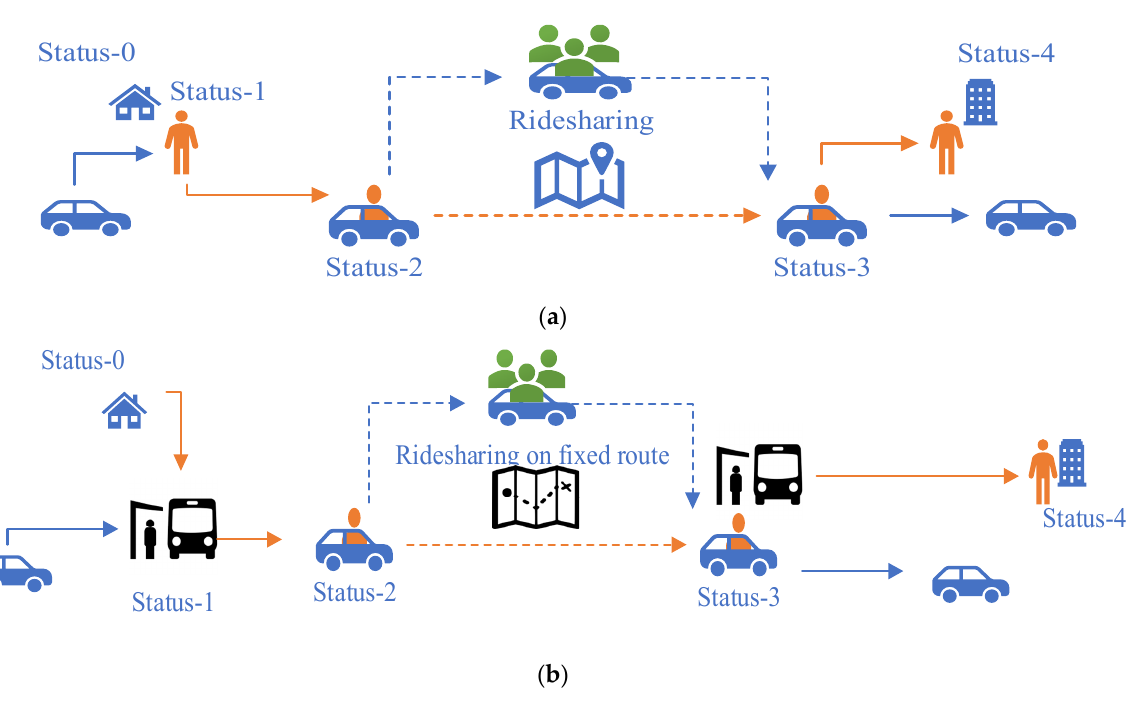
Figure 2. Passenger behavior description for: ( a ) on-demand door-to-door ridesharing service; and ( b ) on-demand fixed-route ridesharing service.